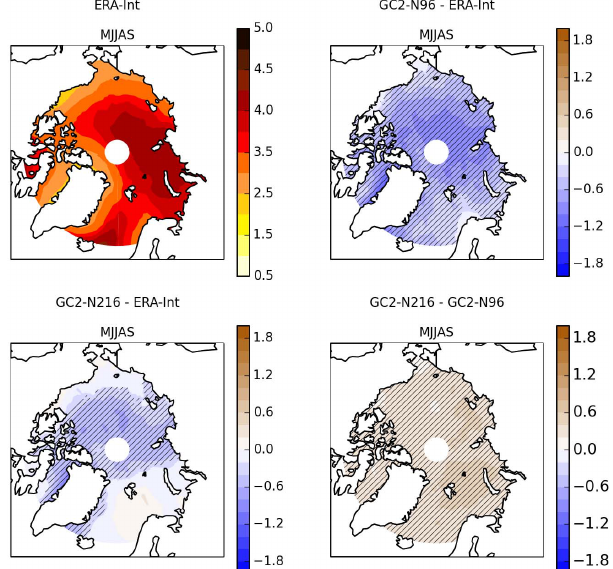
Figure 4. MSLP-based tracking – multi-annual MJJAS mean cy- clone intensity with the background field removed (hPa): ERA- Interim, GC2-N96 minus ERA-Interim, GC2-N216 minus ERA- Interim and GC2-N216 minus GC2-N96. ERA-Interim uses the 1990–2009 MJJAS mean, while GC2-N96 and GC2-N216 use the MJJAS mean over the last 100 years of the 150-year run. Hatch- ing indicates that the difference is shown by Welch’s t test to be statistically significant at the 95%